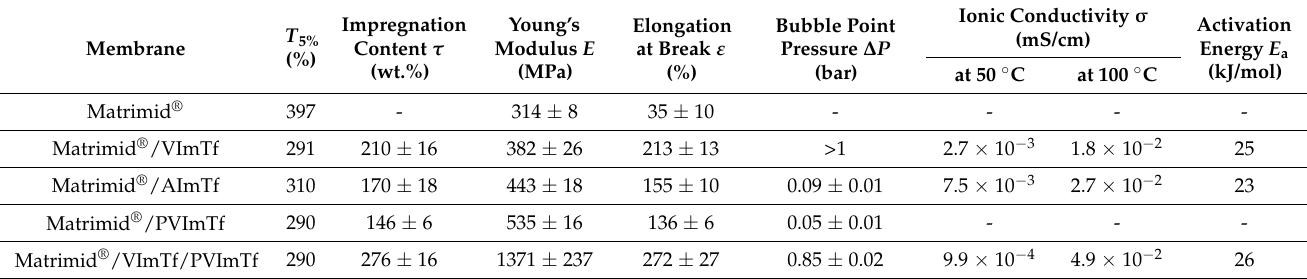
Table 2. Impregnation content, thermal and mechanical stability and ionic conductivity of elaborated SLIMs.